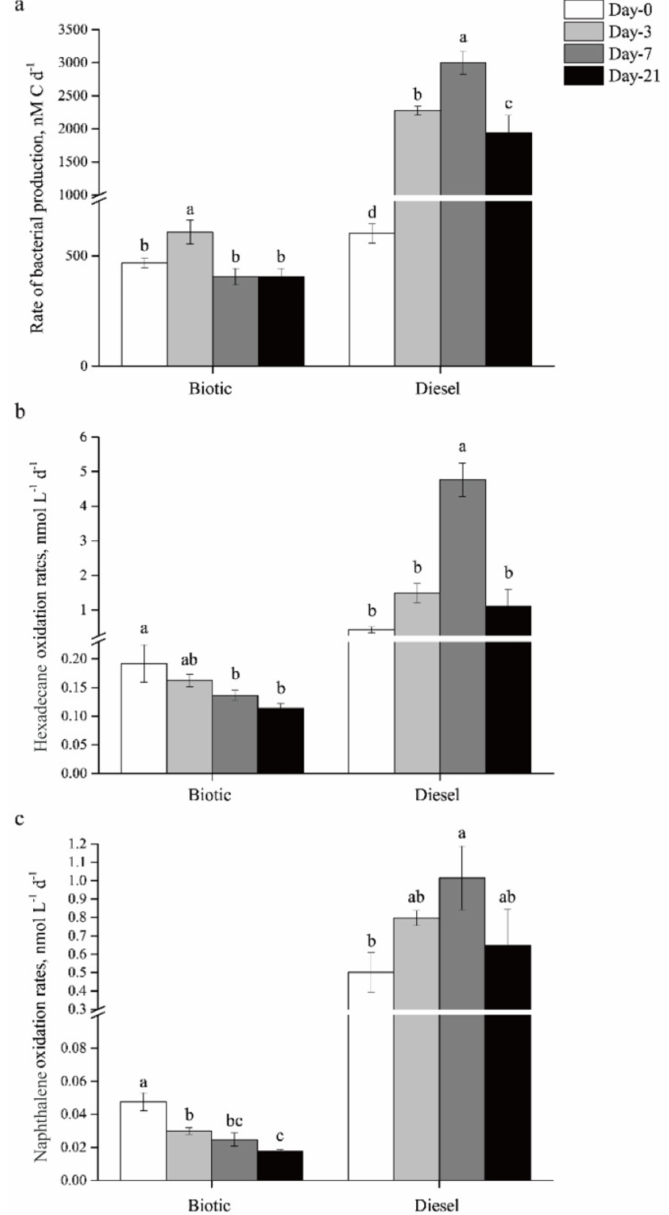
Figure 1. Changes in the rate of bacterial production ( a ), hexadecane oxidation rate ( b ), and naph- thalene oxidation rate ( c ) incubated with (diesel) or without (biotic) diesel across the incubation. Different letters above the columns for each treatment indicate a significant difference ( p < 0.05). Day: 0 d, 3 d, 7 d, and 21 d indicate the microcosms incubated for 0, 3, 7, 21 days, respectively. Error bars represent standards errors of three biological